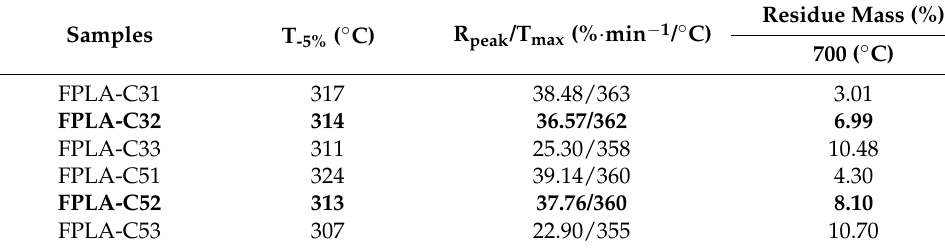
Table 5. TGA data of FPLA composites under air condition.